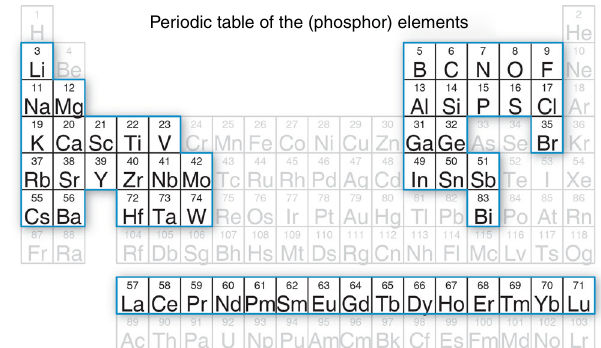
Fig. 2 The elements that compose rare-earth substituted phosphor hosts. Potential phosphor hosts were restricted to the highlighted elements. Any compound containing any other element was excluded from the materials screening